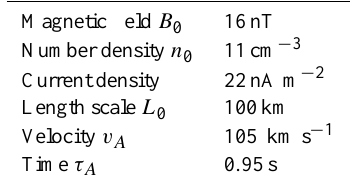
Table 1. Simulation